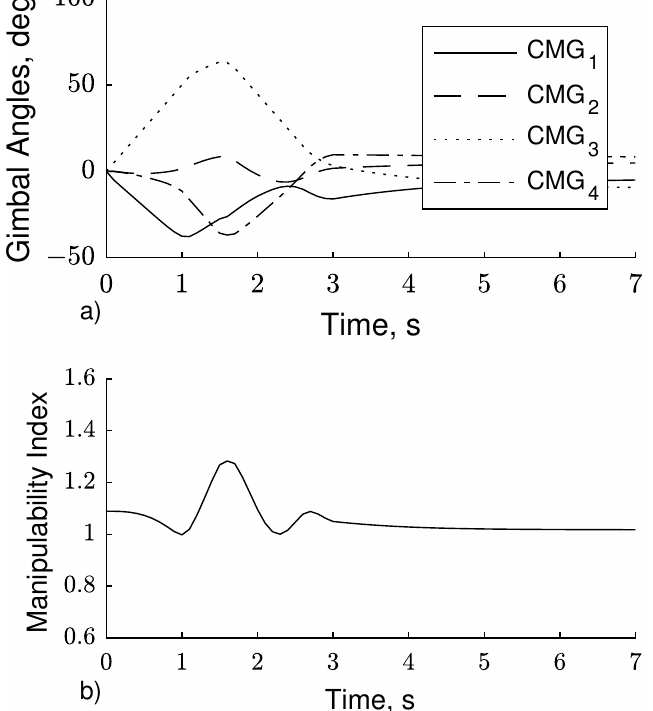
Figure 10. Simulation results with RFC—1st approach. ( a ) Gimbal angles, ( b ) Manipulability index.